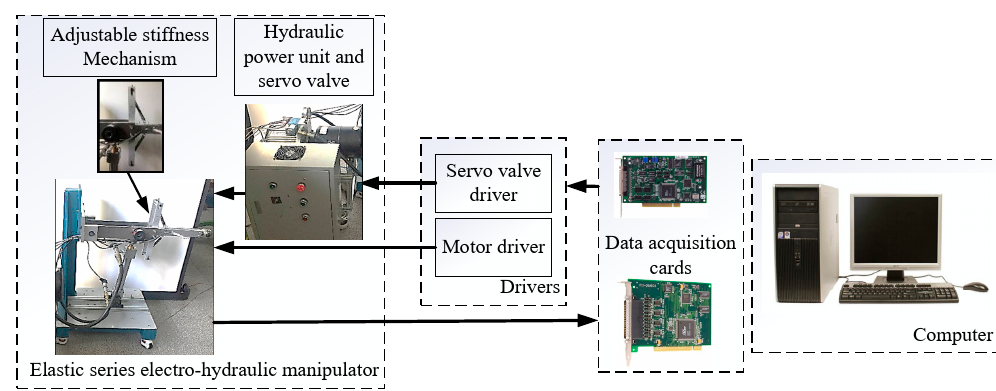
Figure 6. Structure of the EEM test bench.